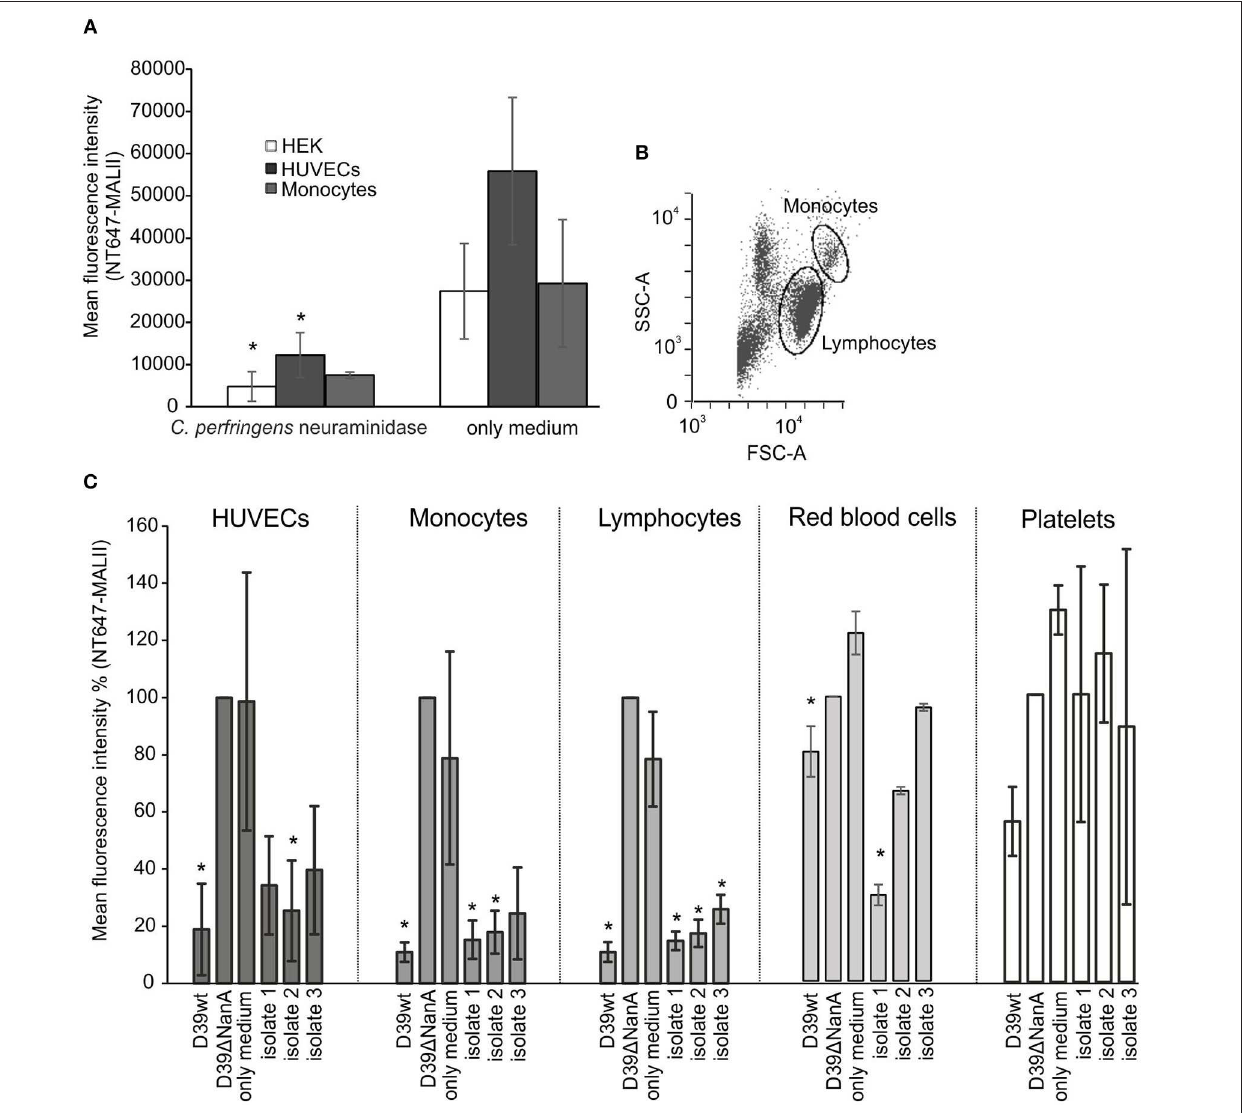
FIGURE 3 | Removal of sialic-acid by S. pneumoniae NanA from various cells. Cultured HEK and HUVEC cells and hirudin-anticoagulated whole blood were incubated with (A) C. perfringens neuraminidase ( n = 3) and (C) S. pneumoniae culture supernatants from wild type D39 strain (D39 wt), D39 nanA deletion mutant (D39 1 NanA) and three clinical isolates (isolates 1–3) ( n = 3). Red blood cells, peripheral blood monocytic cells, and platelets were isolated from whole blood using double density gradient centrifugation. (B) Gating of the monocytes and lymphocytes from the peripheral blood monocytic cells are shown. (A) Sialic acid removal from HEK and HUVEC cells and monocytes was detected by flow cytometry using sialic acid specific NT647-labeled MAL-II lectin. Levels are calculated as (A) mean or (C) relative mean fluorescence intensity against NT647-MAL-II binding to D39 1 NanA treated cells. Statistical significance calculated for HEK, HUVEC, red blood cells, and peripheral blood monocytic cells ( n = 3) (A) against MALII binding with only medium or (B) NT647-MAL-II binding to D39 1 NanA cells using one-way ANOVA (* P -value < 0.05). Error bars indicate SD.